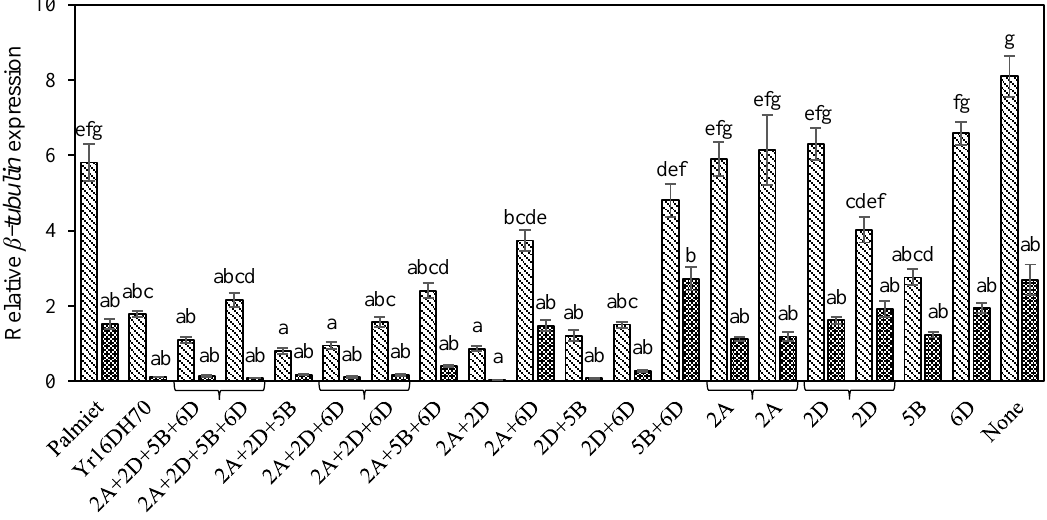
2nd Sampling Figure 3. Relative expression of β -tubulin by Puccinia striiformis f. sp. tritici race 6E22A+ in the wheat parents and recombinant inbred lines containing different combinations of stripe rust resistance quantitative trait loci (QTL) 2A = QYr.ufs-2A , 2D = QYr.ufs-2D , 5B = QYr.ufs-5B and 6D = QYr.ufs-6D . Mean expression in two field replications was measured at two sampling times. Brackets indicate lines with matching predicted QTL profiles. Error bars represent standard errors. Least significant differences (LSD) among lines for relative β -tubulin expression were calculated as 2.68, i.e., means with the same letter do not differ significantly from each other ( p ≤ 0.01) .